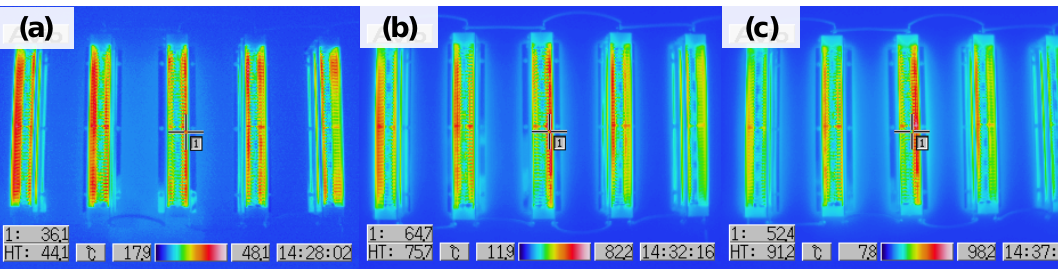
Figure 3. Temperature distribution of the coil-shaped reactors in the air-cleaner ( a ) 1; ( b ) 5; and ( c ) 10 min after the device is switched on without air flow.